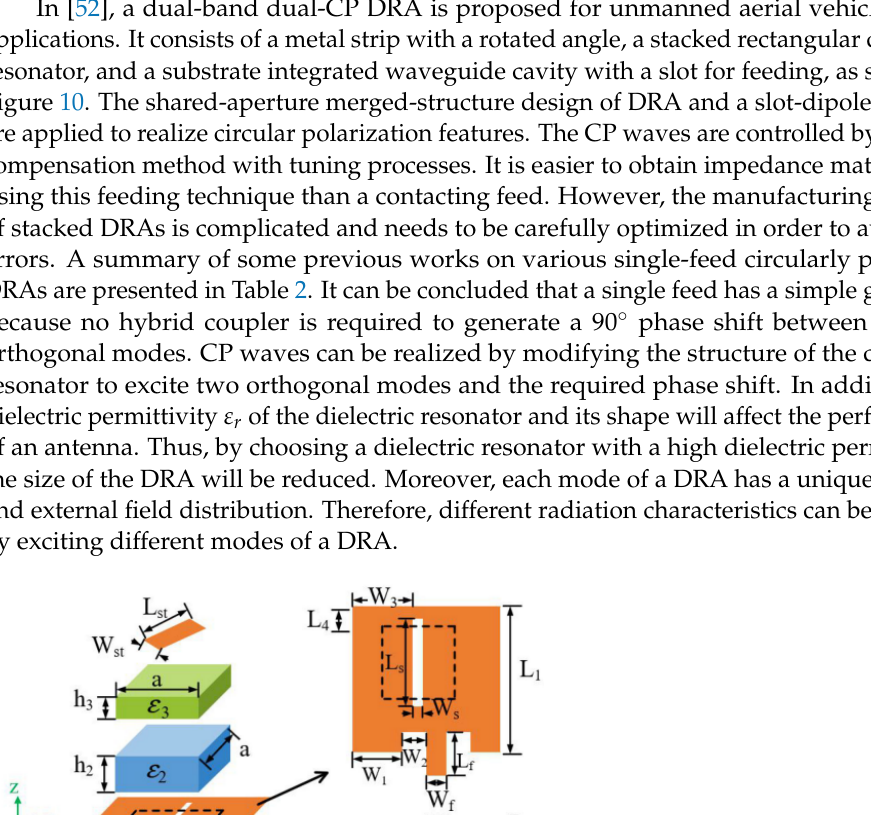
Figure 10. The shared-aperture merged-structure design of DRA and a slot-dipole antenna